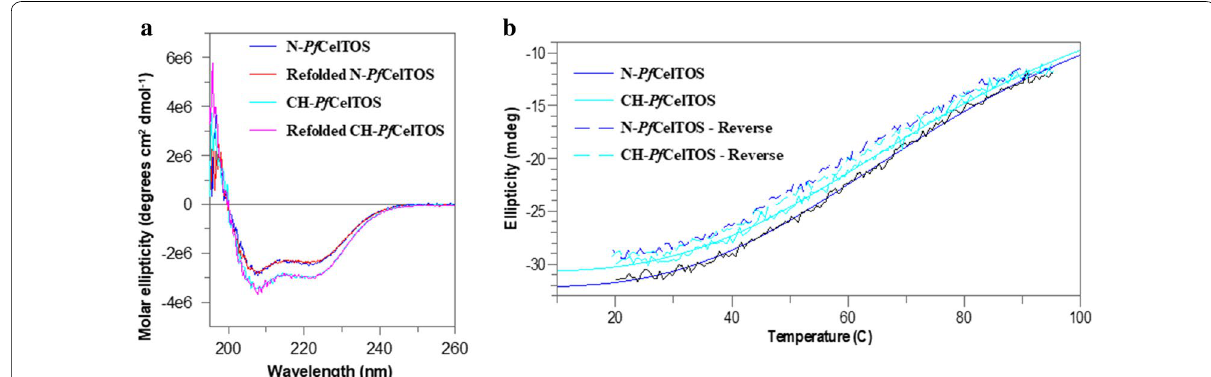
Fig. 2 CH- Pf CelTOS contains more helical content than N- Pf CelTOS. a CD-spectra of N- Pf CelTOS (blue) or CH- Pf CelTOS (cyan) proteins; overlaid with the CD spectra of the refolded N- Pf CelTOS (red) or refolded CH- Pf CelTOS (pink) proteins. b Thermal denaturation curves of the N- Pf CelTOS (blue) and CH- Pf CelTOS (cyan) and the reversed N- Pf CelTOS (dashed blue) and reversed CH- Pf CelTOS (dashed cyan). Curves are significantly